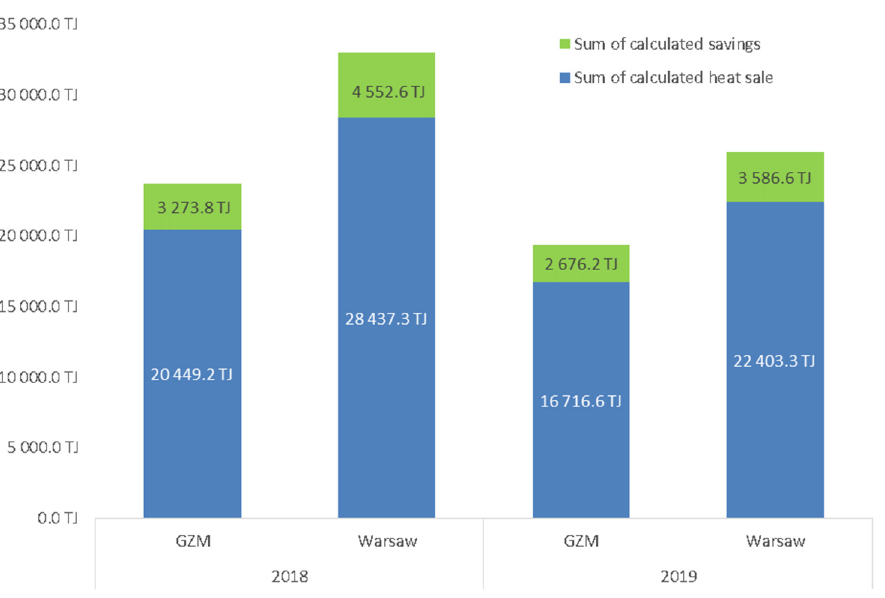
Figure 3. Simulation of results of Hubgrade application in the whole GZM and Warsaw district heating systems.